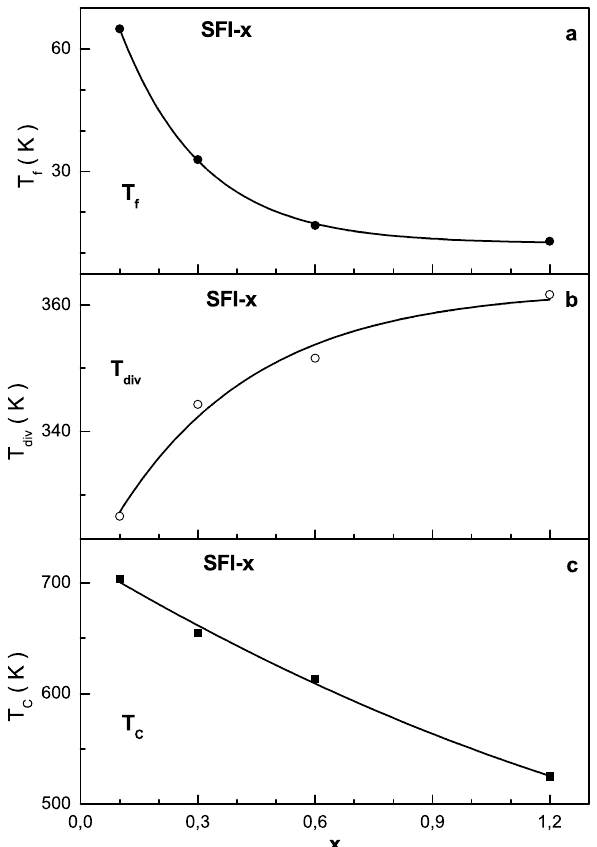
Figure 5. Graph of the T f freezing ( a ) and T div divergence ( b ) and T C Curie ( c ) temperature vs. x for the SFI-x samples.